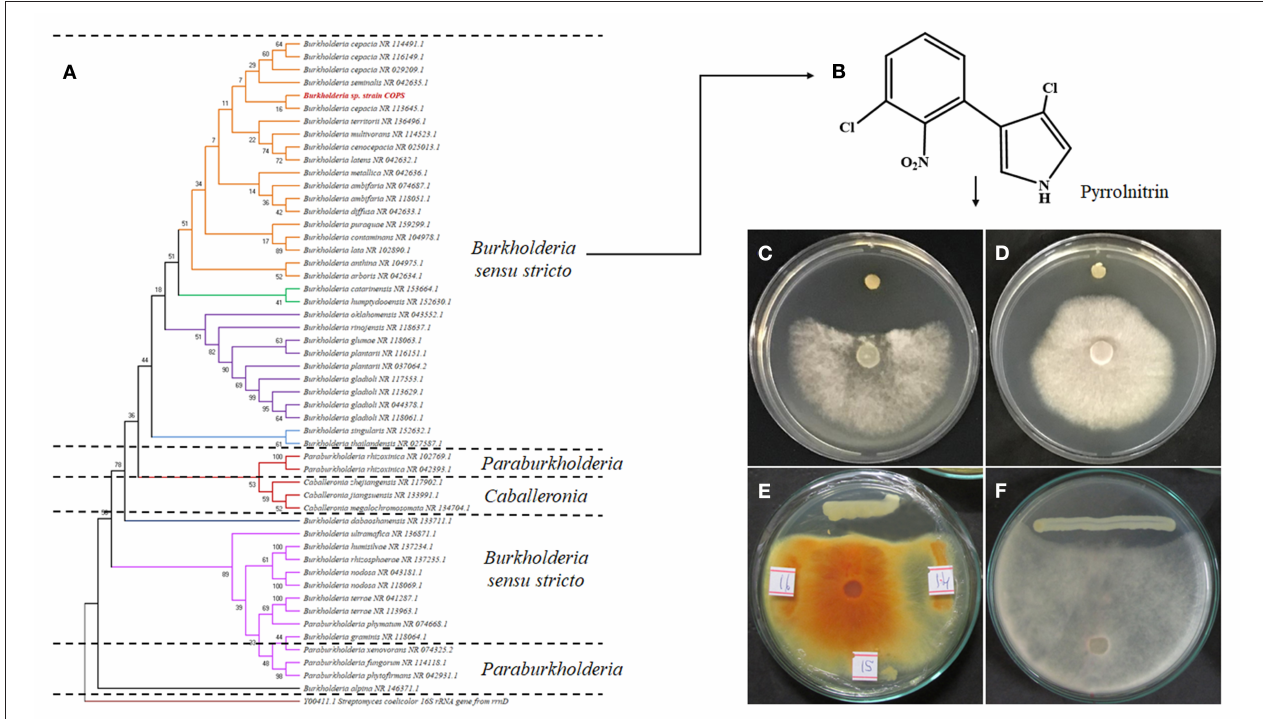
FIGURE 3 | Burkholderiales comprise a diverse taxonomic group ( Burkholderia , Caballeronia , Mycetohabitans , Paraburkholderia , Pararobbisais , Robbsia , and Trinickia ) (A) that is capable of adapting to various ecological niches and is considered an emerging source of natural products for therapeutic and biotechnological applications. In terms of agricultural practices, antifungal pyrrolnitrin (B) is known for its broad spectrum of activity against several phytopathogenic fungi. Both the dual culture assay and the crude extract of the novel B. cepacia strain COPS showed potent antifungal effects against Ceratocystis paradoxa (C,F) , Fusarium proliferatum (D) , and Alternaria alternata (E)